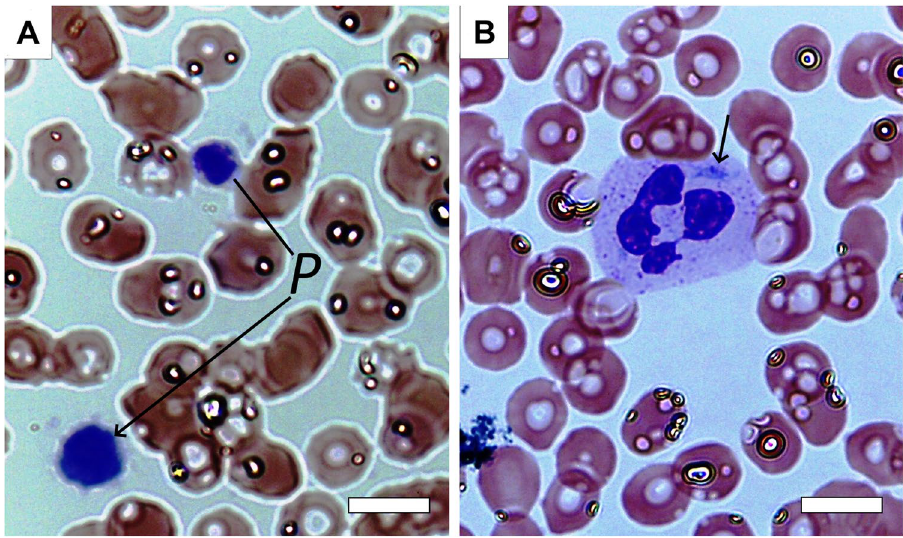
Figure 1. Characteristic micrographs of a blood smear from a patient with a MYH9 gene mutation examined. ( A ) Two giant platelets ( P ) against the background of erythrocytes with slight anisocytosis and poikilocytosis. ( B ) A segmented nuclear granulocyte with a light blue fusiform cytoplasmic inclusion, a Döhle-like body (shown by the arrow). Romanowsky-Giemsa staining. Magnification bars = 6 µm.